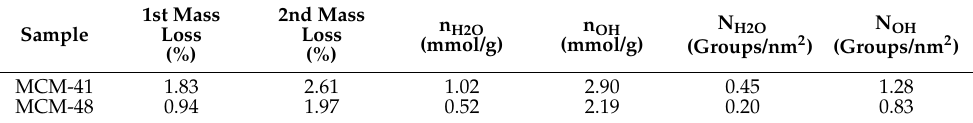
Figure 9. The TG (solid)—DSC (dotted) curves for the MCM-48 (black); MCM-48_APTES (red); MCM-48_FA (blue) and MCM-48_APTES_FA (purple).